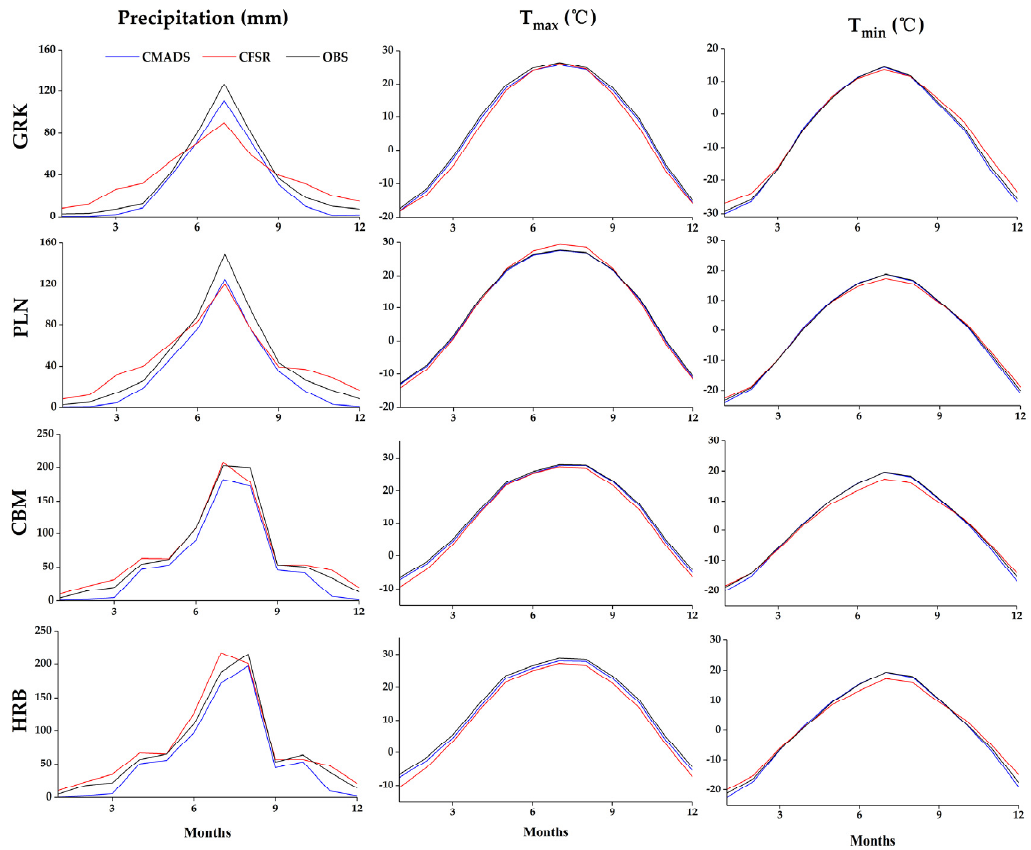
Figure 5. The monthly average distribution of CMADS, CFSR, and OBS. Marks: The figures in the first, second, third, and fourth lines show the monthly average distributions of the three meteorological elements (precipitation, maximum temperature, and minimum temperature) from GRK, PLN, CBM, and HRB, respectively.